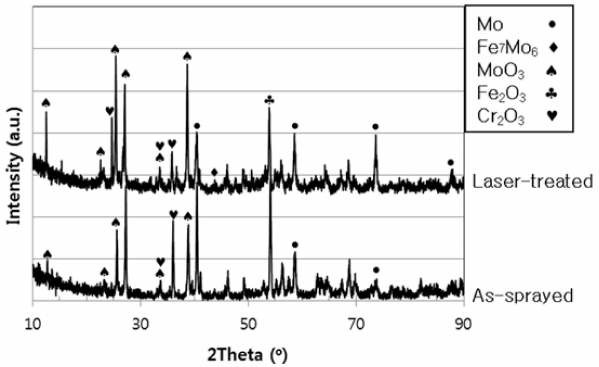
Figure 4. XRD analysis results of surfaces of oxidation test